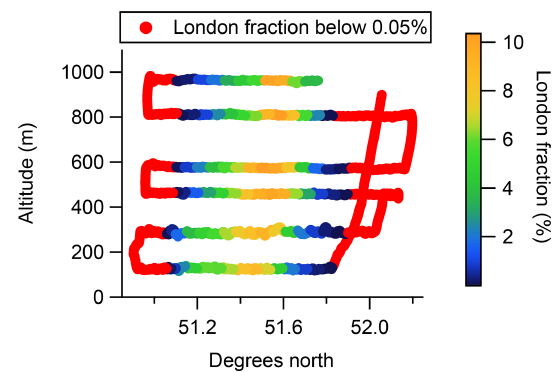
Figure 3. Altitude–latitude projection showing the influence of London on the downwind sampling, as determined from the NAME air histories. The colour scale represents the fraction of aggregated NAME air history D ij within the Greater London administrative region for each NAME release period. Background periods, where the London fraction is less than 0.05%, are shown in